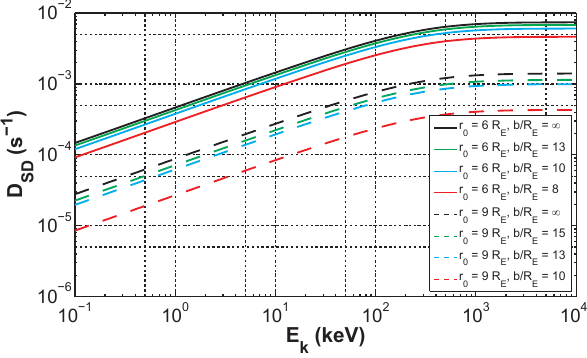
Fig. 8. Plots of strong diffusion rate D SD as a function of electron energy E k for the two specific Dungey magnetic field lines with the indicated multiple b